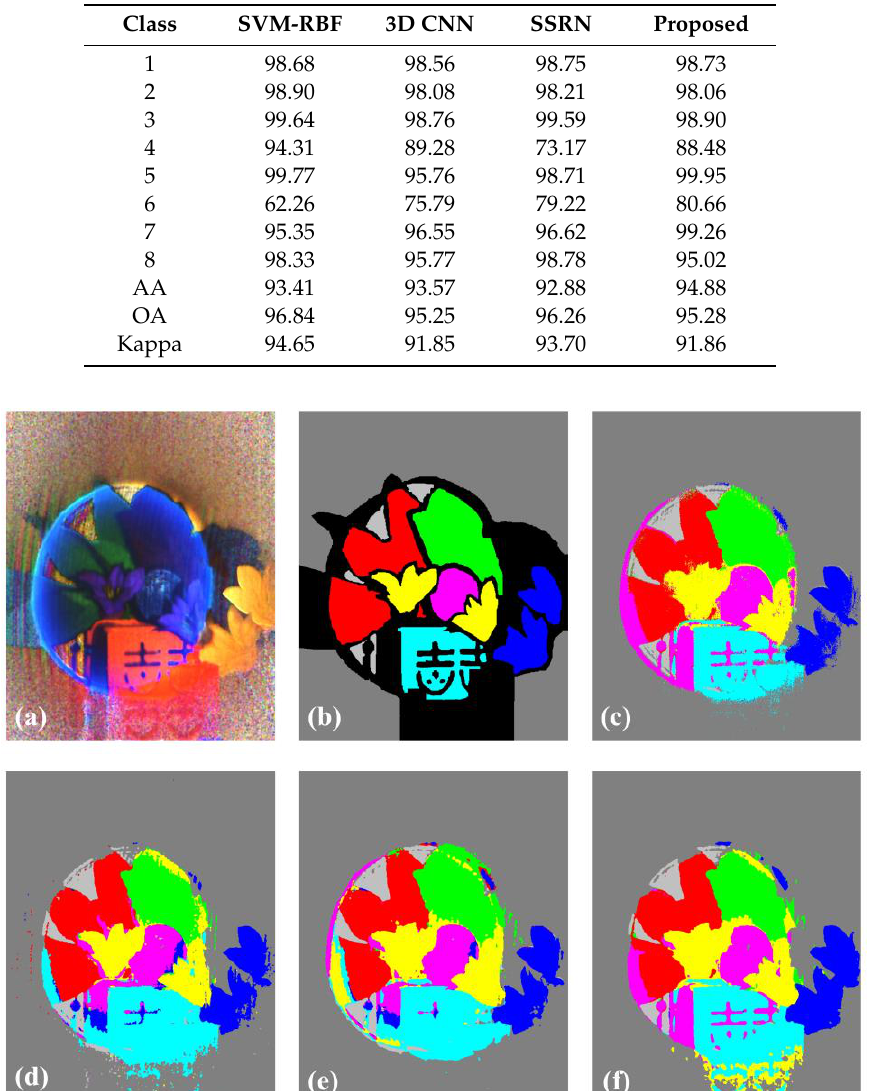
Figure 10. Classification maps of different methods. ( a ) The false-color map. ( b ) The label image. ( c ) Support vector machine with a radial basis function kernel (SVM-RBF). ( d ) 3D convolutional neural network (3D CNN). ( e ) Spectral-spatial residual network (SSRN). ( f ) The proposed hybrid DenseNet. Please zoom in to see the details.